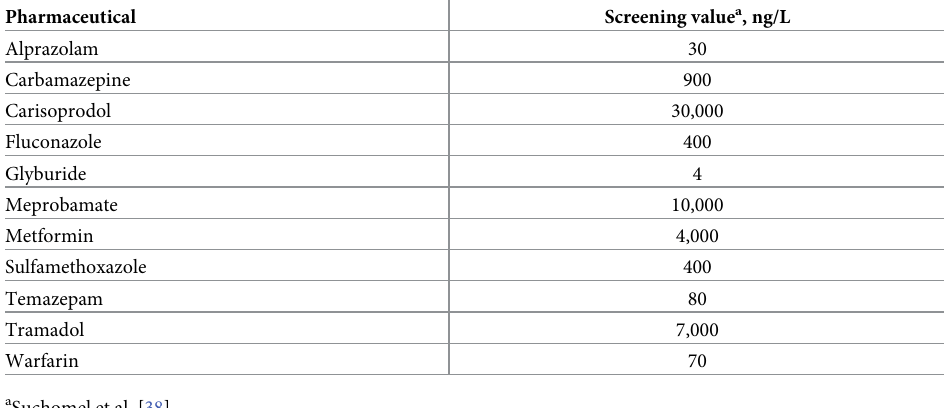
Table 2. Human-health screening values used to compare detected pharmaceutical concentrations in groundwa- ter downgradient from large subsurface treatment systems and rapid infiltration basins.